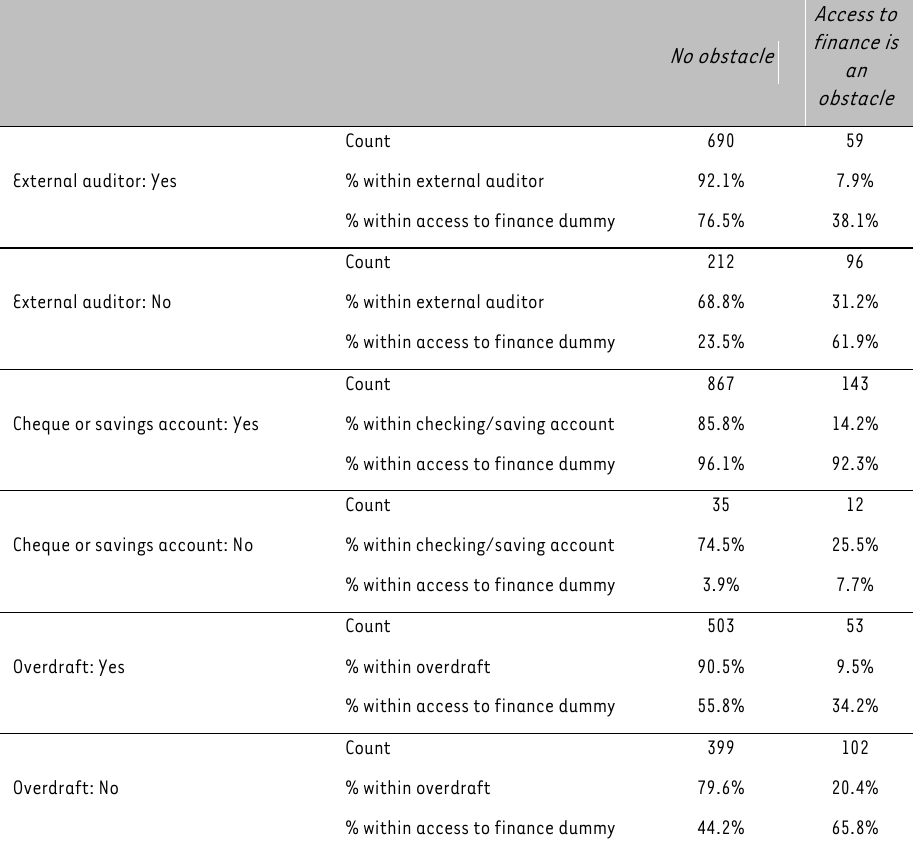
TABLE 4: Access to banking services